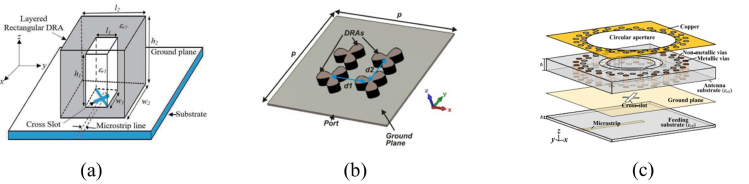
Figure 7. Configurations of CP antenna: ( a ) Layered DRA [65]; ( b ) Sequential array [67]; ( c ) Top- loaded patch